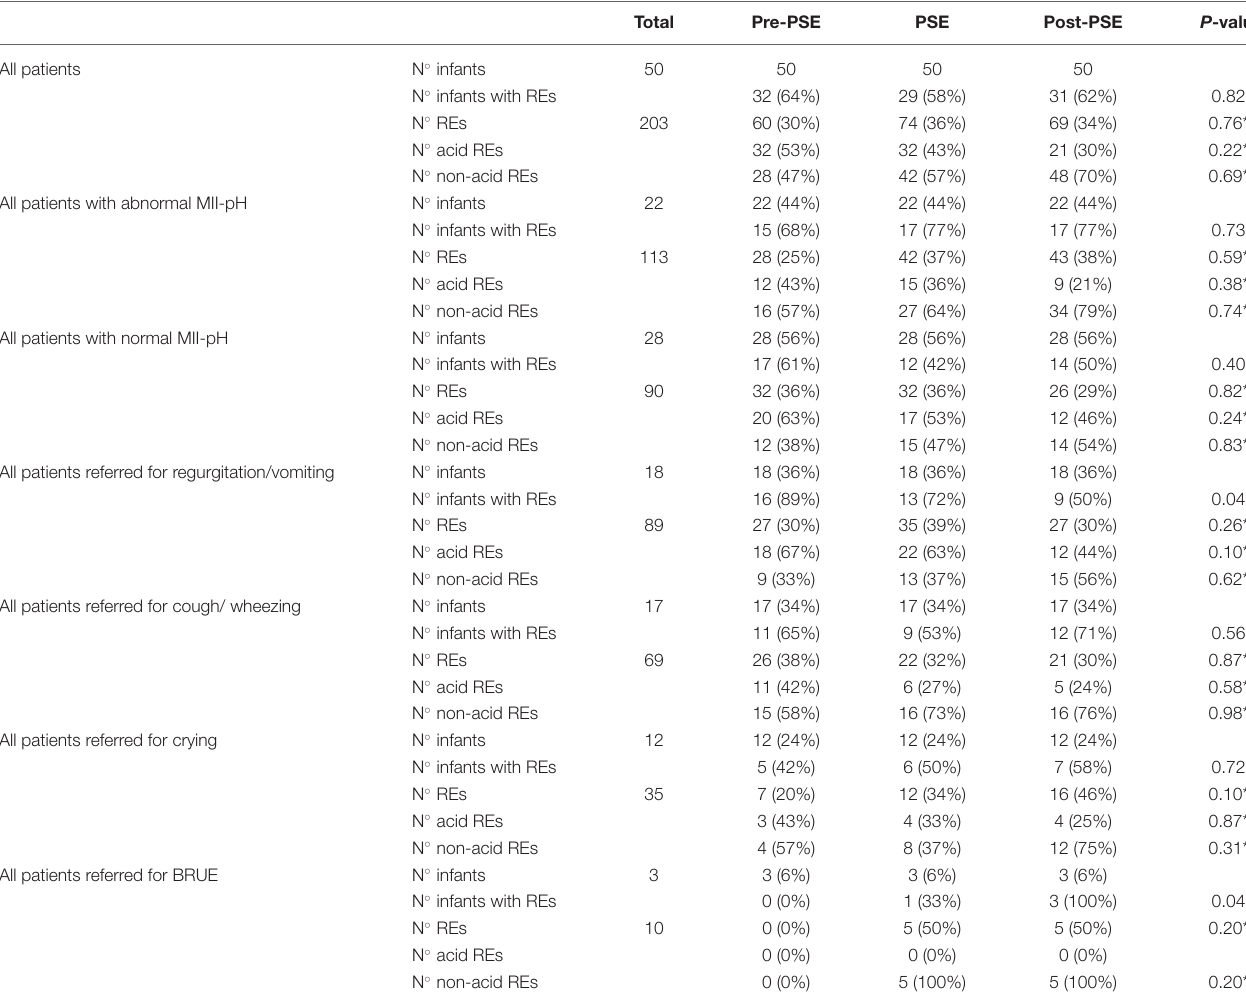
TABLE 3 | Results of the MII-pH monitoring with post-hoc analysis.